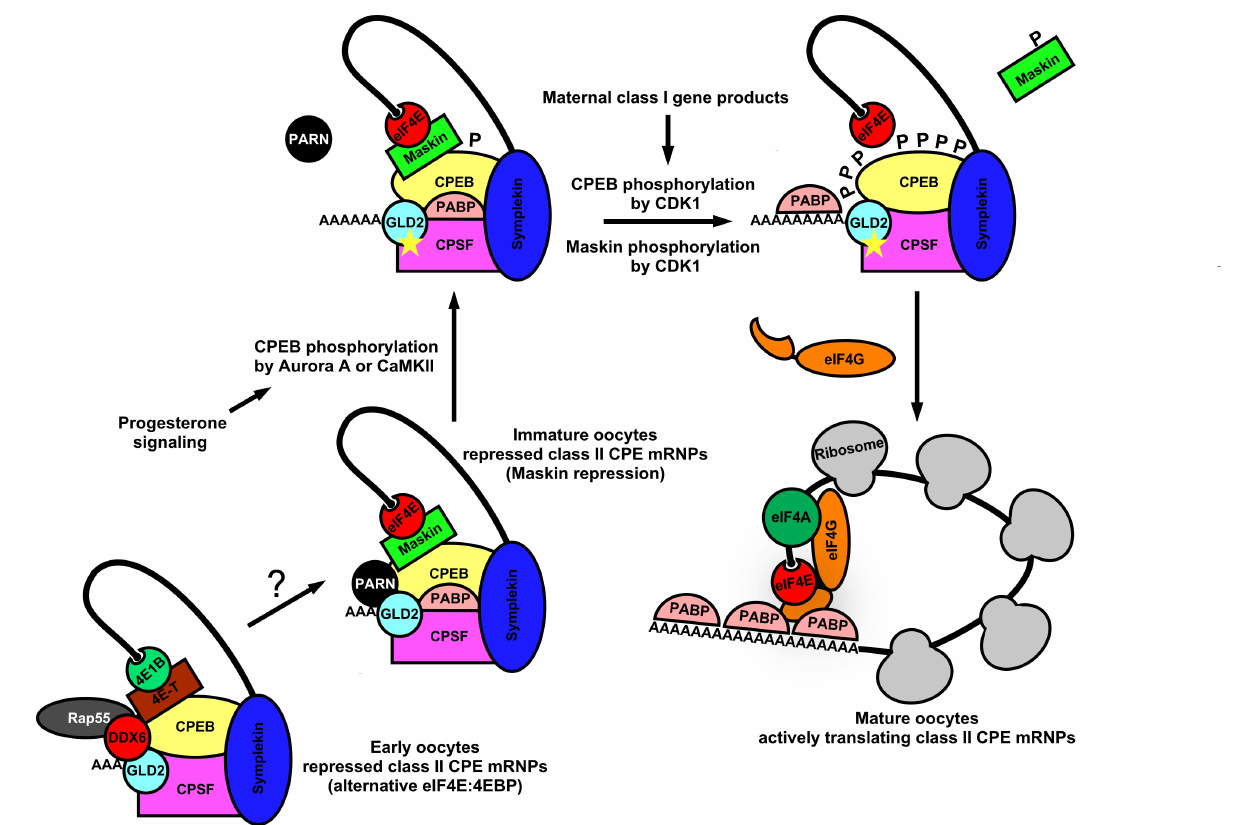
FIGURE 3 | Dynamic mRNP remodeling promotes alternate mRNA repression, poly(A) elongation, and ribosome recruitment during Xenopus oocyte maturation. In immature Xenopus oocytes, class II CPE mRNAs are translationally repressed by eIF4E:Maskin cap-binding complexes directed by the CPEB, CPSF, Symplekin 3 (cid:48) -UTR-binding module. These complexes also contain PABP, PARN, and GLD2 indicating the potential for both poly(A) elongation and deadenylation. At the 5 (cid:48) -end, Maskin (4EIP) inhibits cap-dependent initiation by competing with eIF4G for eIF4E binding. At the 3 (cid:48) -end PARN shortens the poly(A) tail. Although GLD2 is resident within the complex, PARN activity appears to be dominant. It also may be that CPE-containing mRNAs cycle between deadenylation and polyadenylation. Upon progesterone stimulation, CPEB is phosphorylated by Aurora A kinase or CaMKII which leads to remodeling of the complex and ejection of PARN. GLD2 then catalyzes extension of the mRNA poly(A) tail. Concurrently, class I CPE containing mRNAs are translated and lead to activation of CDK1. CPEB and Maskin are phosphorylated by CDK1, and PABP is recruited to the poly(A) tail for further stabilization. Maskin is displaced and PABP associates with eIF4G, allowing